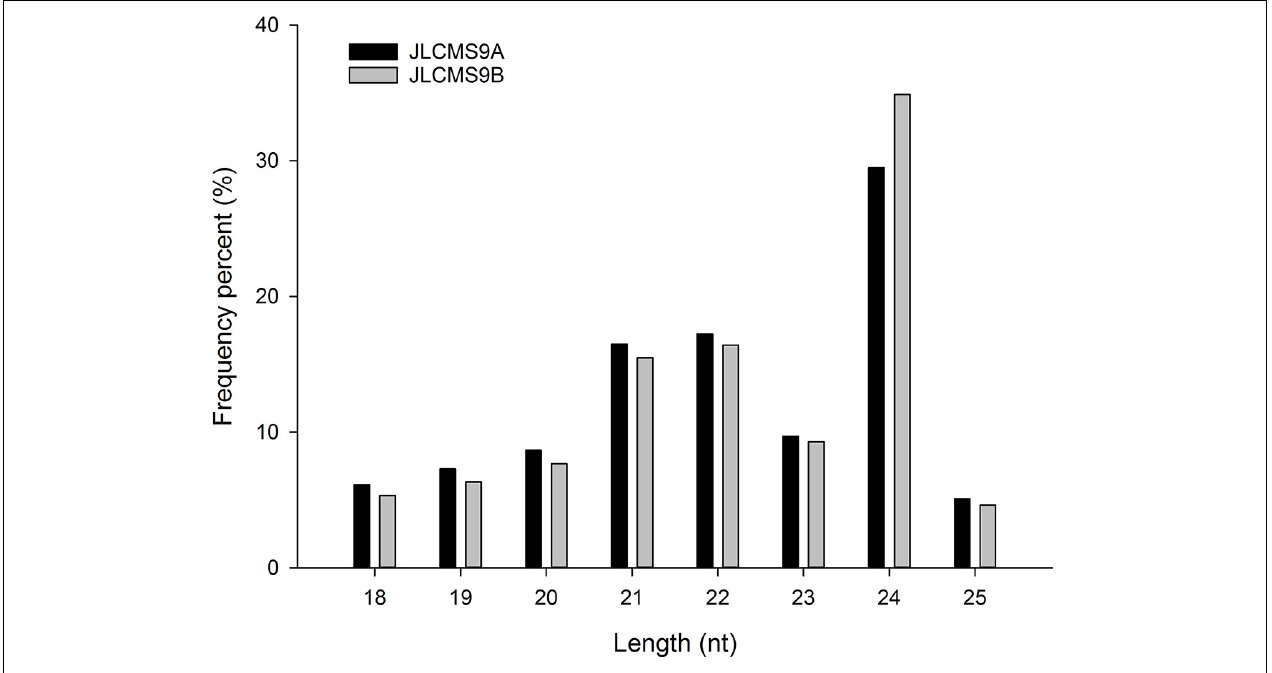
FIGURE 2 | The length distribution of small RNAs in JLCMS9A and JLCMS9B flower buds.